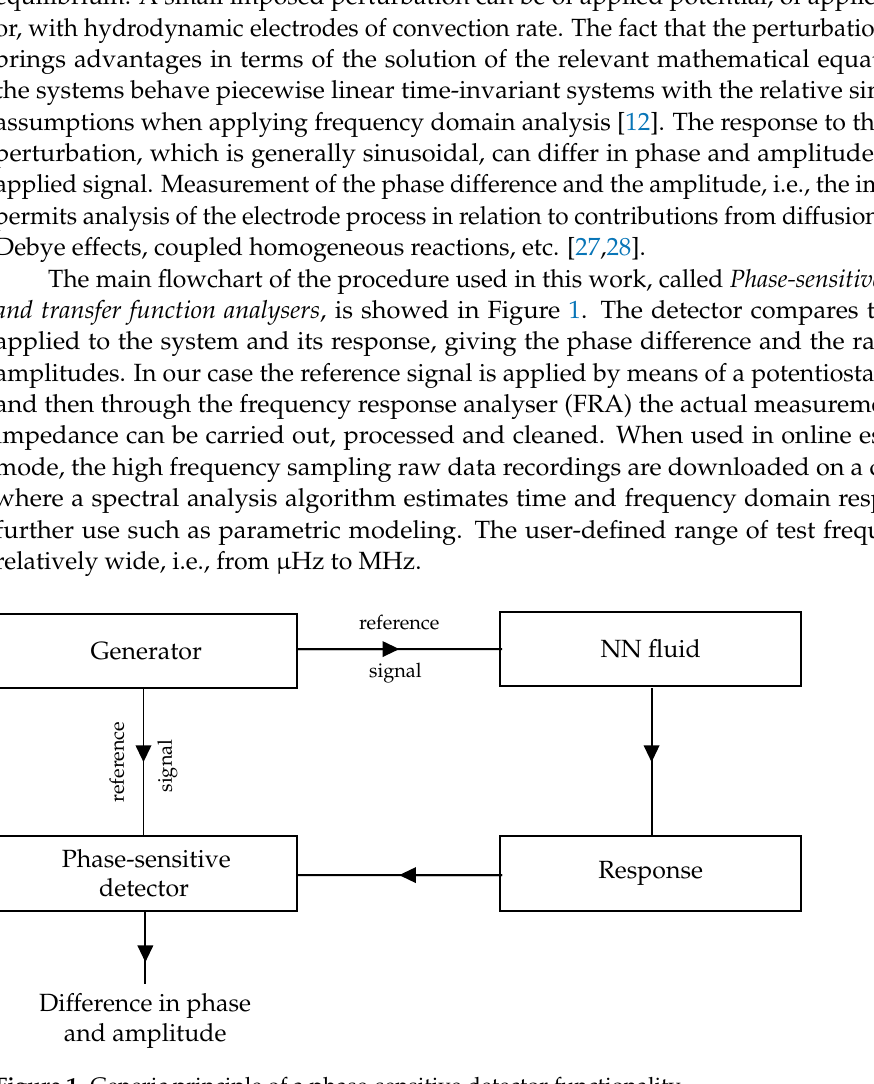
Figure 1. Generic principle of a phase-sensitive detector